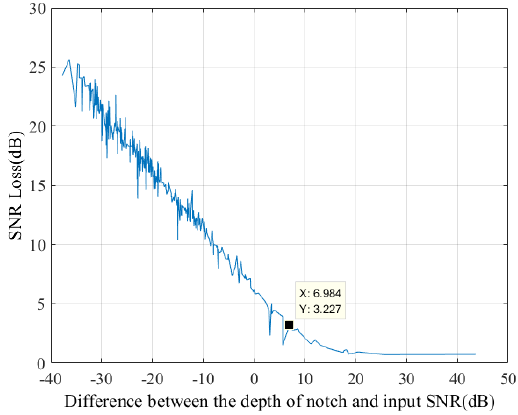
Figure 7. The relationship of SNR loss via difference between the depth of notch and inputted target SNR.